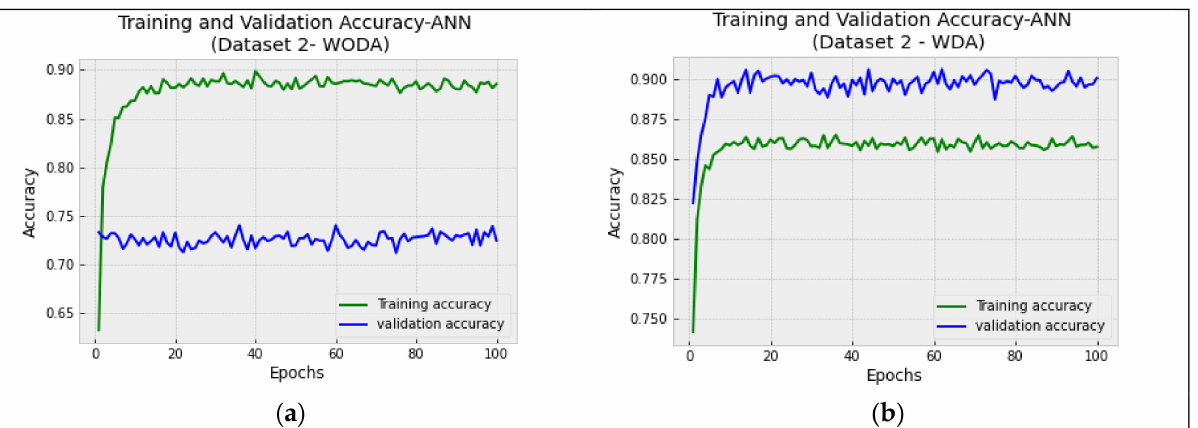
Figure 11. ANN model validation and testing accuracy and loss without data augmentation (dataset 2): ( a ) model accuracy (WODA); ( b ) model accuracy